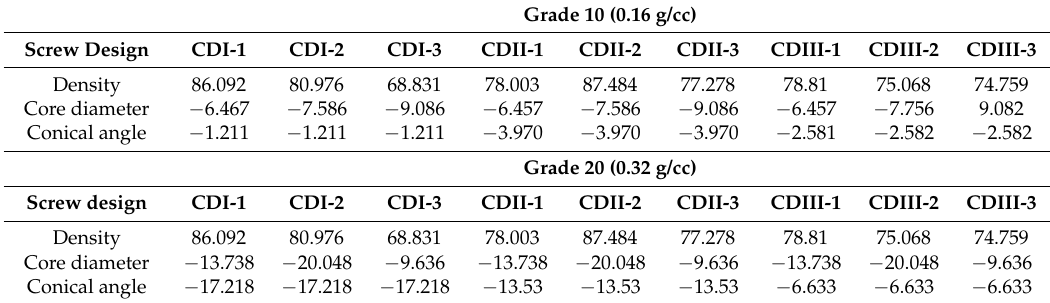
Table 2. Local sensitivity of density, core diameter, and conical angle on the pullout force.